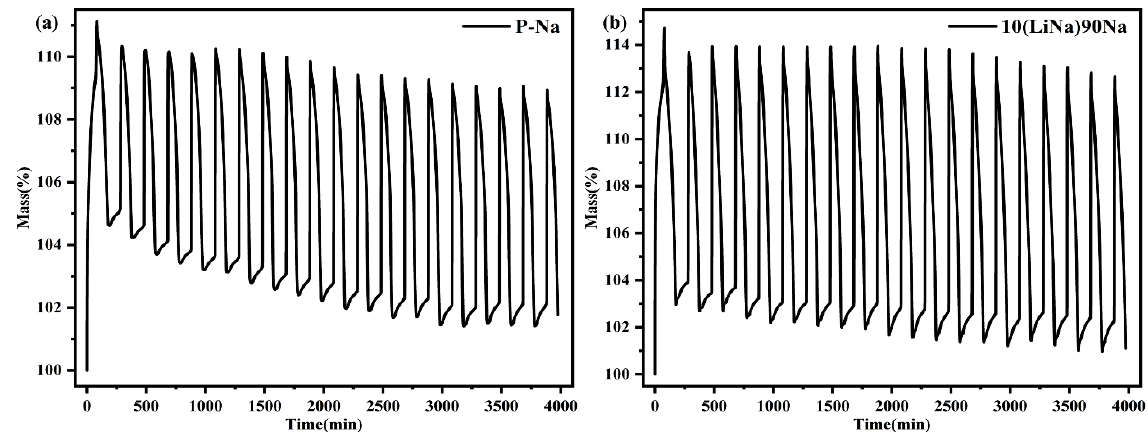
Figure 8. Cyclic stability of ( a )P–Na and ( b )10(LiNa)90Na.